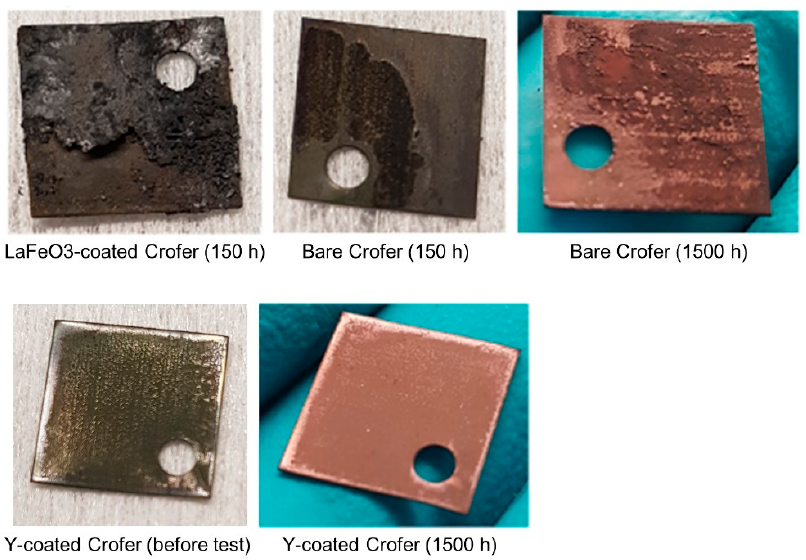
Figure 4. Pictures of the samples after aging in H 2 -H 2 O atmosphere at 700 °C.